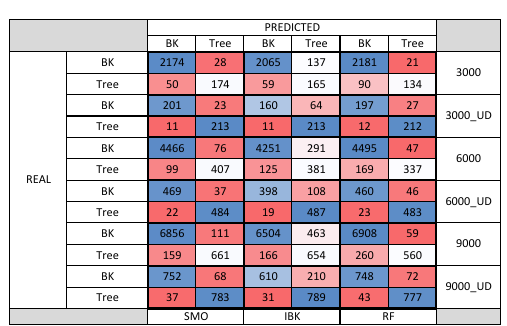
Figure 2. Original image(a) and Mask Image created using Qgis